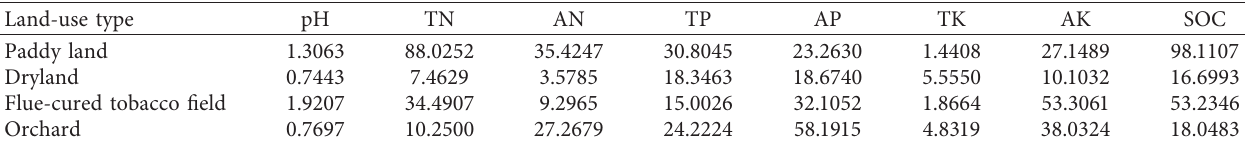
Table 4: Nutrient coefficient of variations of soil in upper and lower layers of different land-use types (100%).